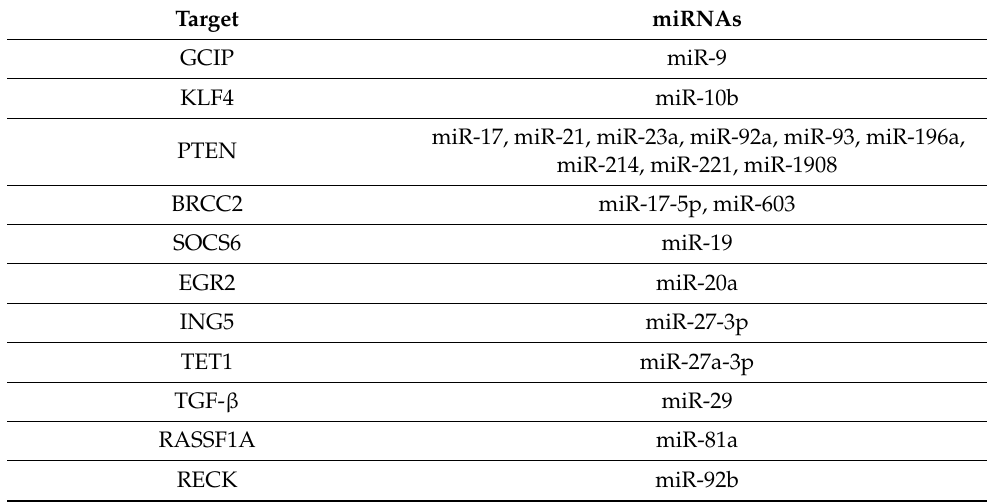
Table 2. Different onco-miRNAs upregulated and their targets in human OS (data recovered by [61]).